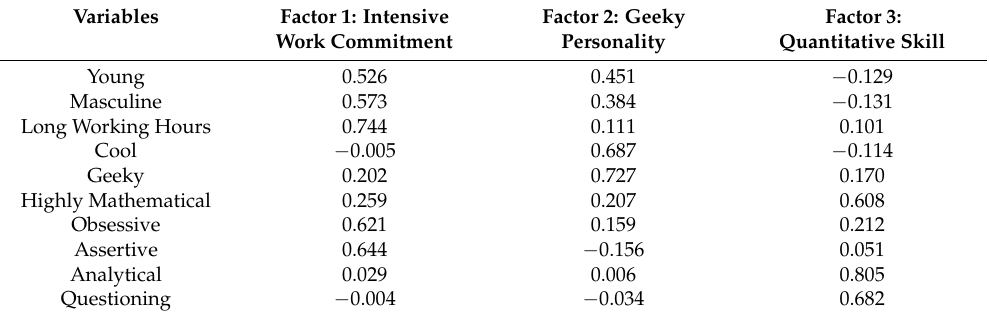
Table A1. Rotated Factor Loadings from Principal-Component Factor Analysis on Traits Describing Successful Tech Workers (Simard et al. 2007).